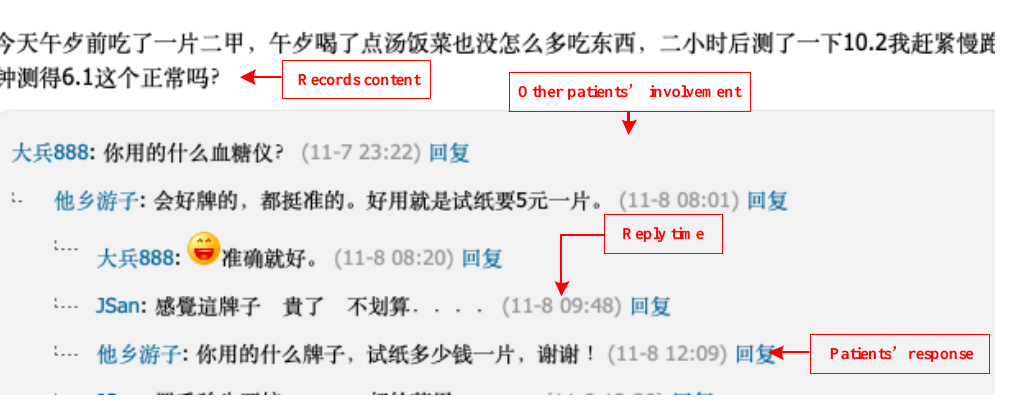
Figure 3. An example of other patient’s involvement.